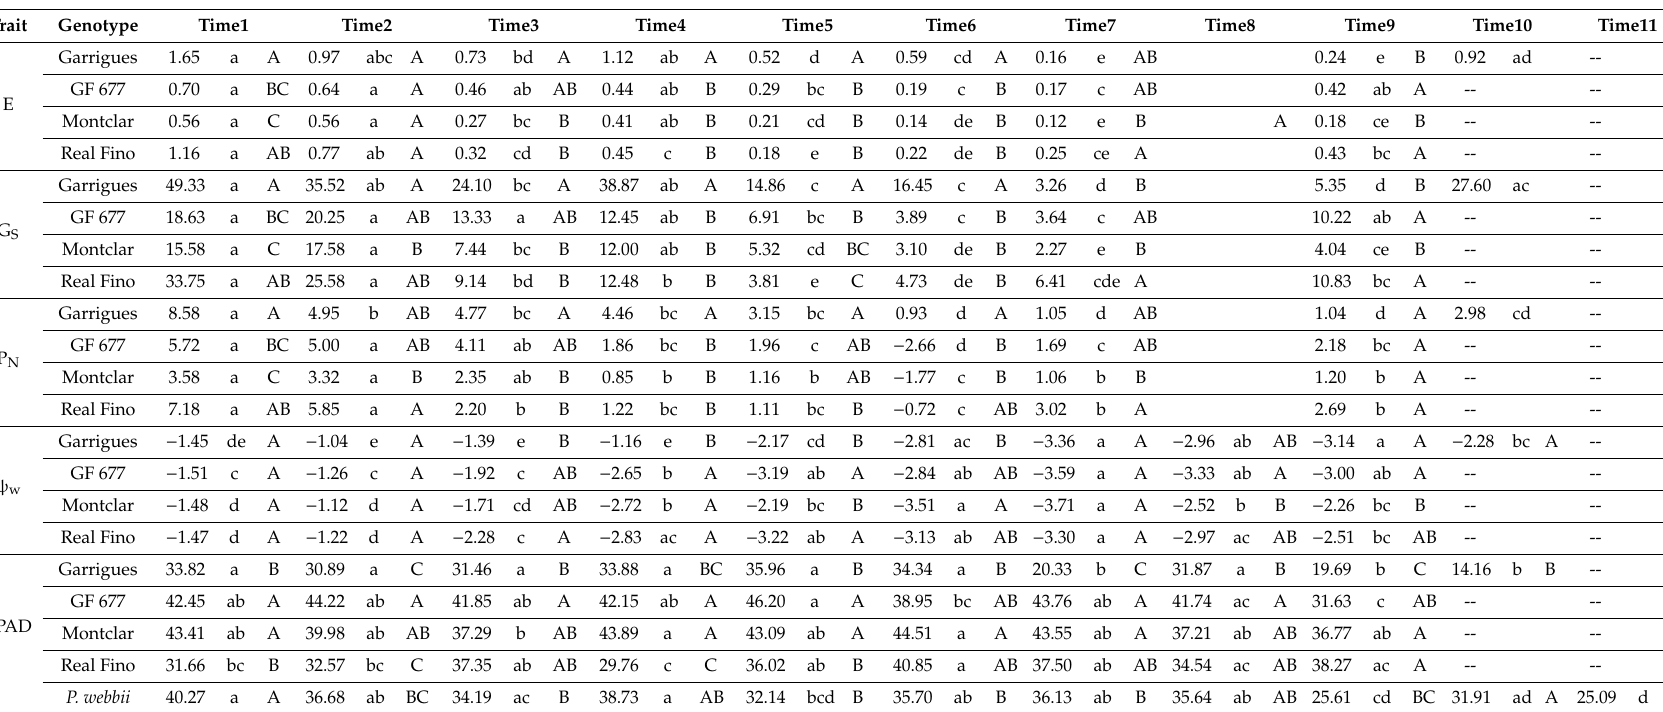
Table 3. Mean values for the di ff erent traits studied. Means with at least one identical lowercase letter within a column are not significantly di ff erent from each other time points. Means with at least one identical uppercase letter within a row of one trait are not significantly di ff erent from each other between genotypes ( p < 0.05). E: transpiration rate; G S : stomatal conductance; P N : net photosynthesis rate; ψ w : leaf water potential; SPAD: chlorophyll